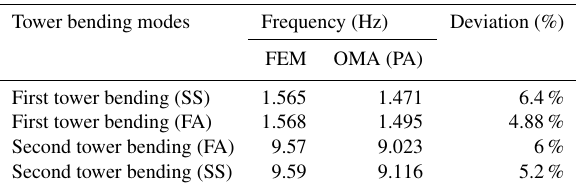
Table 3. Test frequencies under PA vs. FEM. Table 4. Sensitivity analysis of the wind turbine tower bending fre- quencies to